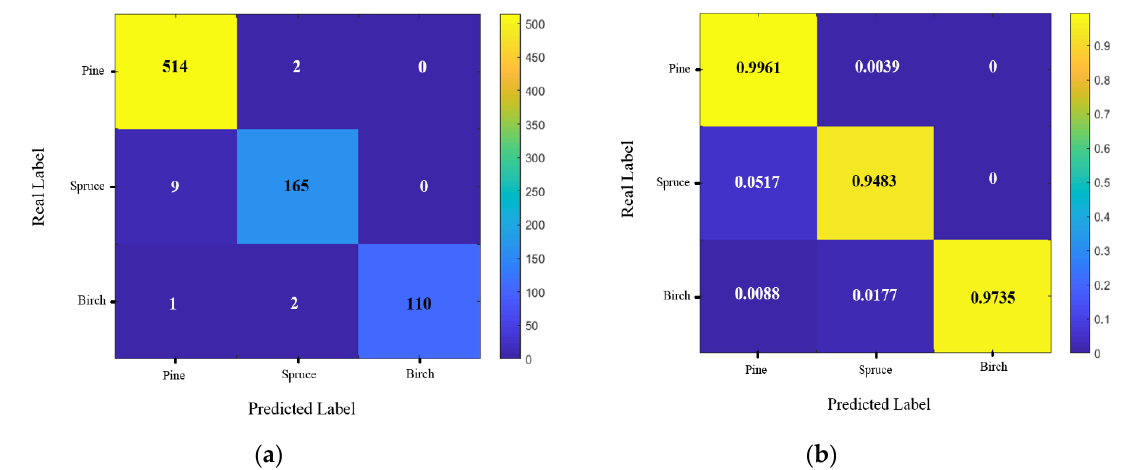
Figure 12. Confusion matrices of the 3D-CNN with RGB and CHM channels ; ( a ) case numbers, ( b ) normalized percentages.